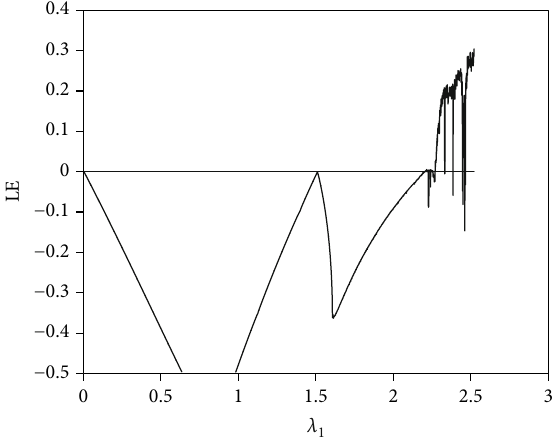
Figure 3: Bifurcation diagram with respect to λ = 0 : 1, λ